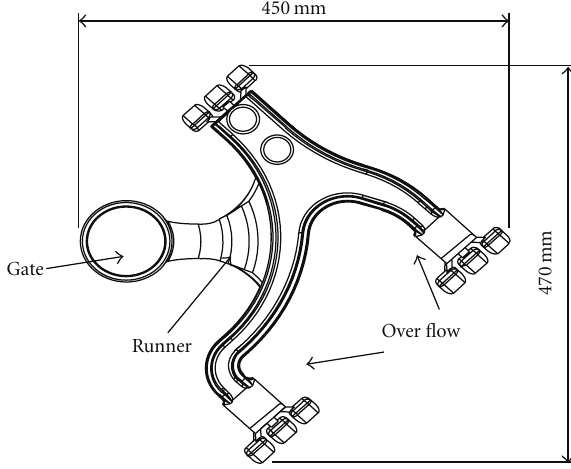
Figure 2: Geometry of runner system and arm part.